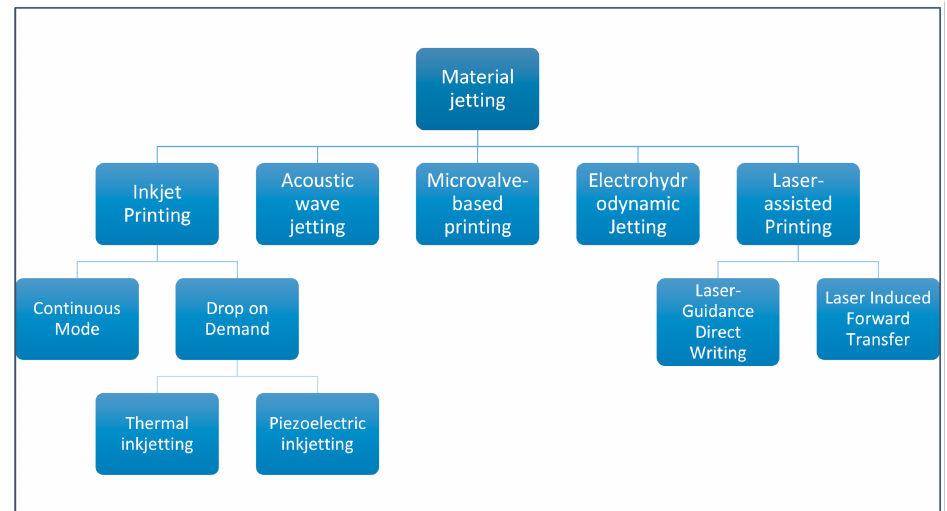
Figure 6. Overview of the different subtypes of material jetting.